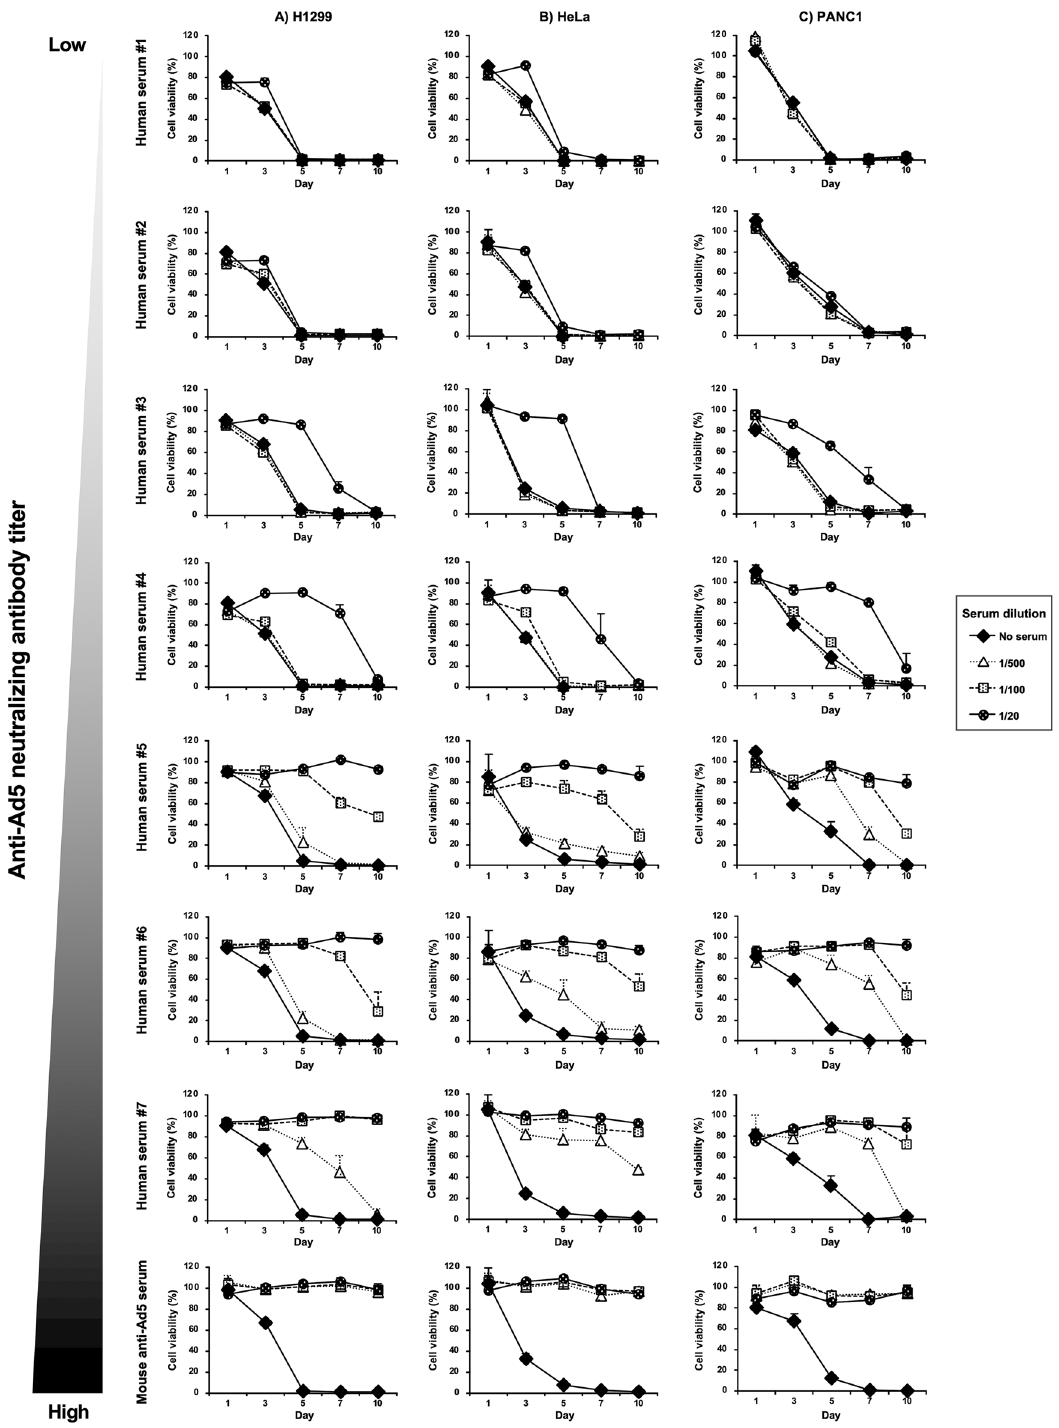
Figure 2. In vitro tumor cell lysis activities of OAd-tAIB-Luc in the presence of mouse and human serum. OAd-tAIB-Luc was pre-incubated with mouse and human serum, followed by infection with ( A ) H1299, ( B ) HeLa, and ( C ) PANC-1 cells at 200 VP/cell. At the indicated time points, cell viabilities were determined by WST-8 assay. The viability of the mock-infected group was normalized to 100%. These data are expressed as the means ± S.D. (n =